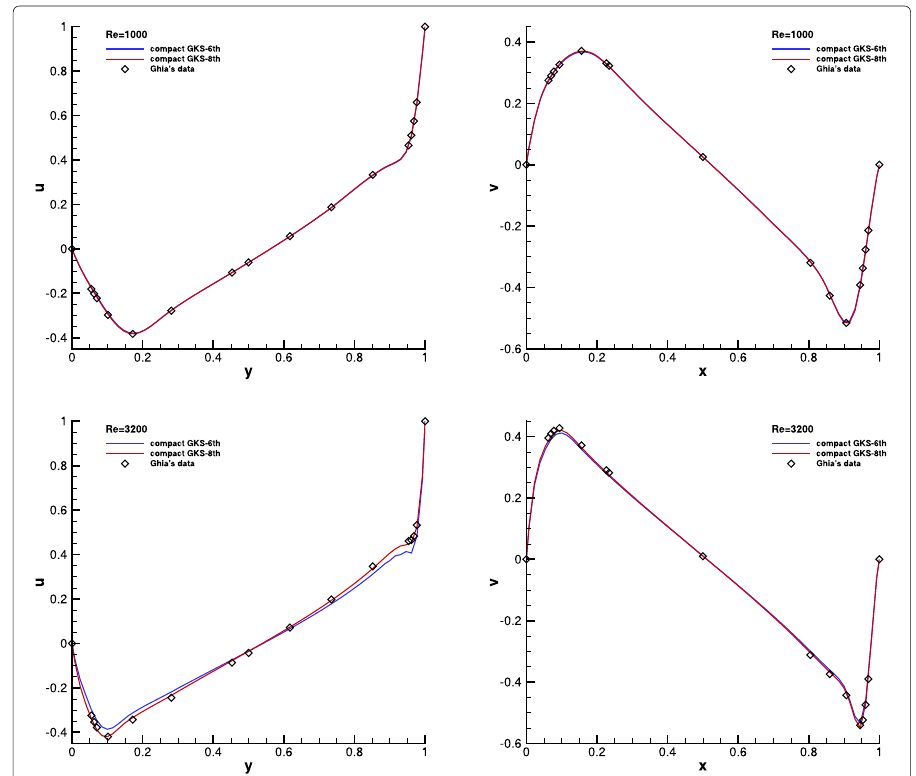
Fig. 18 Lid-driven cavity flow: U-velocity along vertical centerline and V-velocity along horizontal center-line with 65 × 65 uniform mesh points at Re = 1000 and 3200